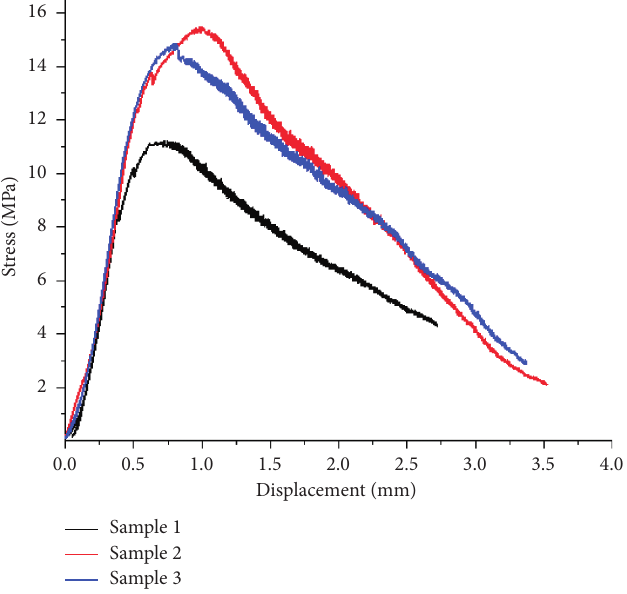
Figure 4: Flexural strength test of UHPC.